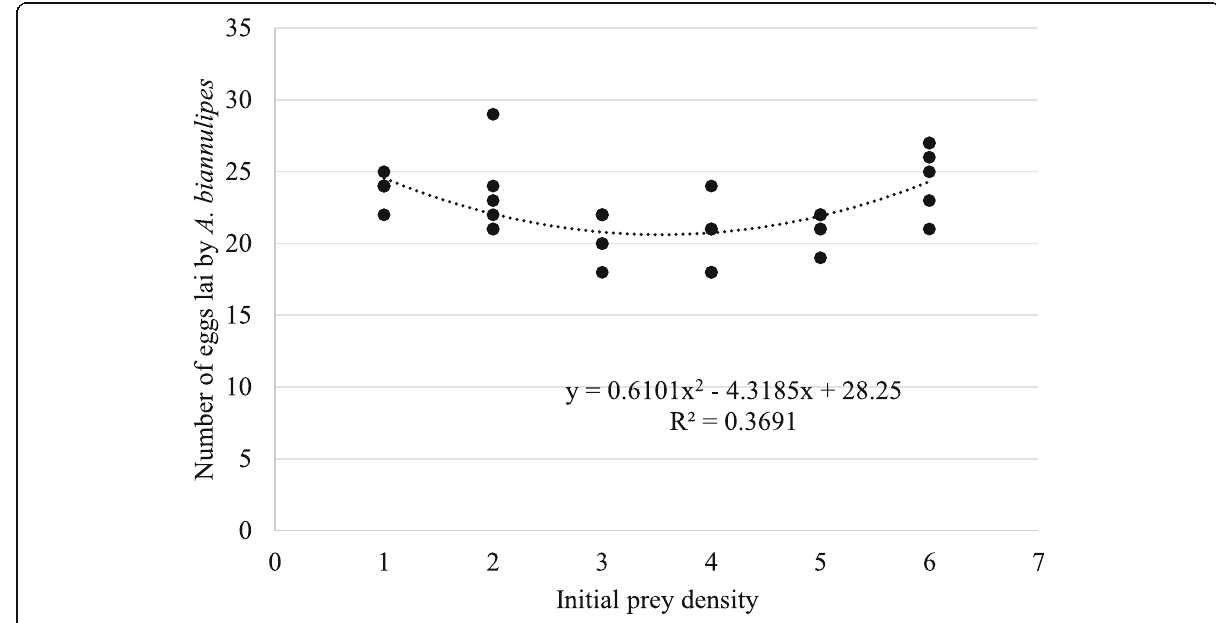
Fig. 6 Total number of eggs laid by A. biannulipes females at different densities of P. truncatus pupae